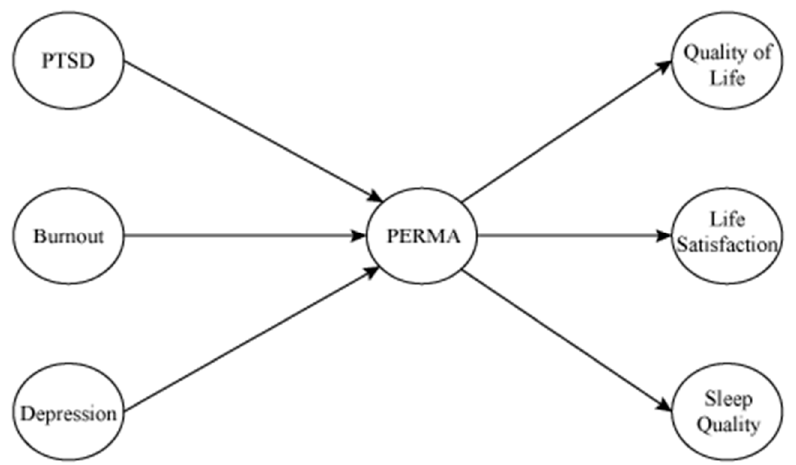
Figure 1. Proposed model of testing variables. Note. PTSD: post-traumatic stress disorder Syndrome; PERMA: positive emotion, engagement, relationship, meaning, and achievement.